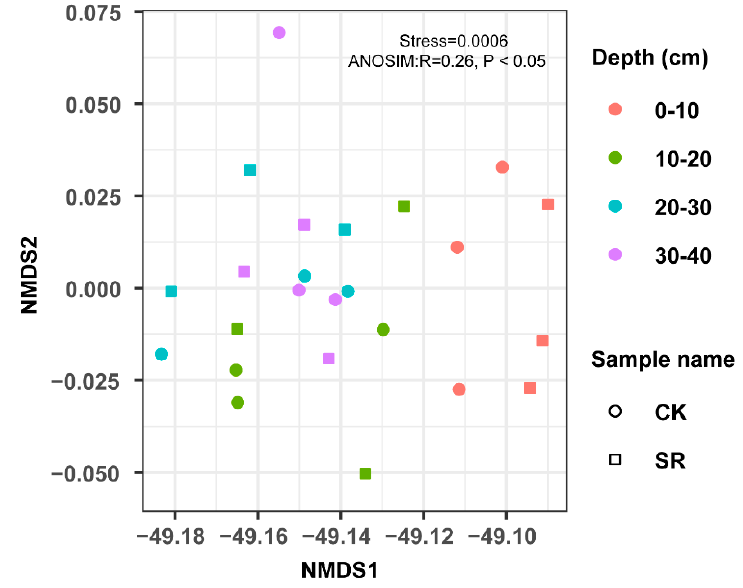
Figure 3. Analysis of nonparametric multidimensional scaling (NMDS) of the bacterial communities in the soil samples at 0–10-cm, 10–20-cm, 20-30-cm, and 30–40-cm depths. CK, control; SR, sugarcane straw retention.